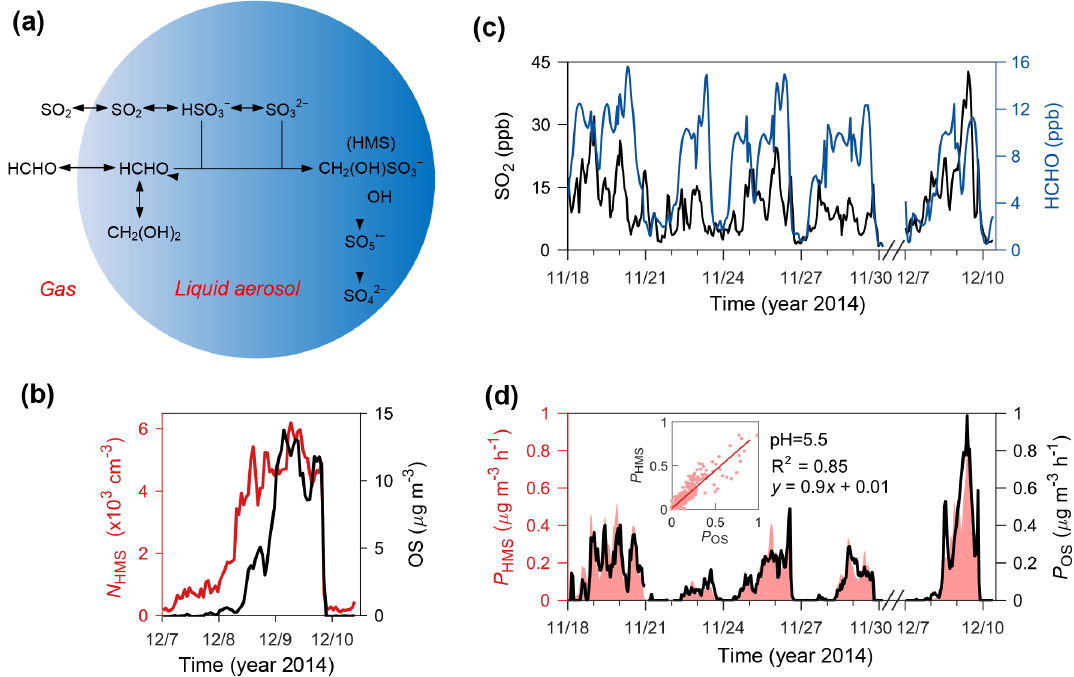
Figure 3. Production and existence of HMS in Beijing winter haze aerosols. (a) Schematic of heterogeneous HMS chemistry in northern China winter haze. (b) N HMS (left, red line) and OS concentrations (right, black line). N HMS was only available for a haze episode in December 2014 due to instrumentation constraints. (c) Gas-phase concentrations of observed SO 2 (left, black line) and modeled HCHO (right, blue line). (d) P HMS (left, pink-shaded area) and P OS (right, black line). The pink-shaded area shows the uncertainty in P HMS due to the estimated range of pH (4.1–5.5). The inserted figure indicates the linear correlation of P HMS and P OS at a pH of